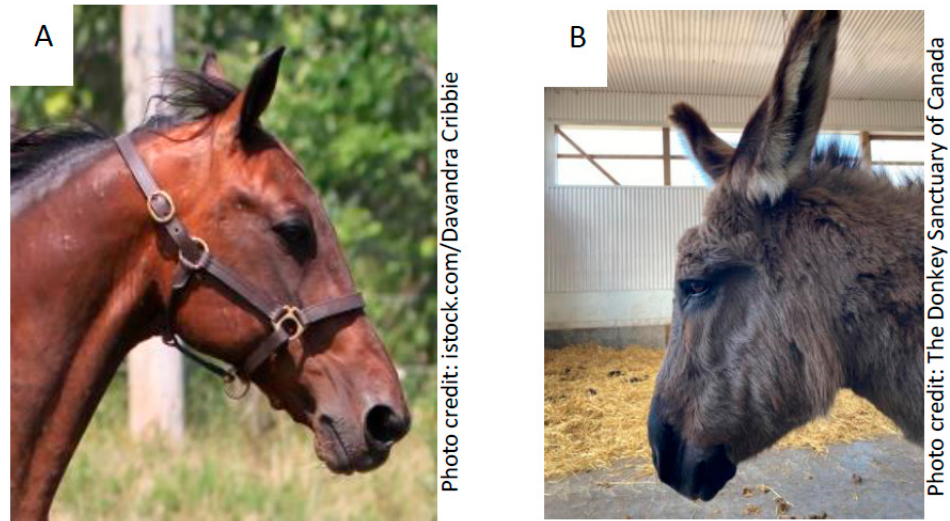
Figure 3. Comparison between the Standardbred ( A ) and donkey ( B ) head profiles. Donkeys have shorterandnarrowerfacesthanStandardbreds, buttheydidnotdi ff erinthenasal, cranialor, mandibular shorter and narrower faces than Standardbreds, but they did not differ in the nasal, cranial or, indices. While the nasal profile index also did not di ff er, donkeys did exhibit a smaller cranial profile mandibular indices. While the nasal profile index also did not differ, donkeys did exhibit a smaller index, as portrayed by the distinct forehead in the cranial profile index, as portrayed by the distinct forehead in the donkey.